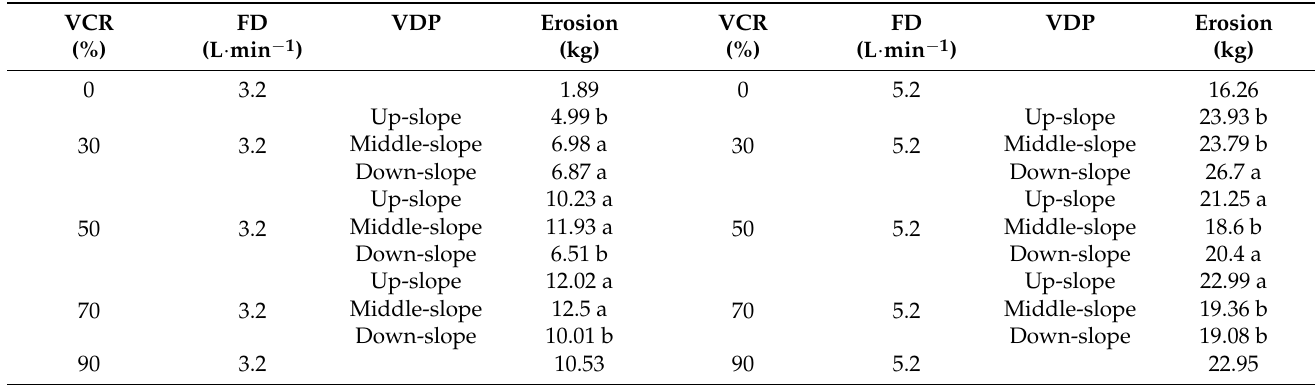
Table 3. Gully slope erosion under the different flow discharges, different grass coverage rates, and different grass arrangement